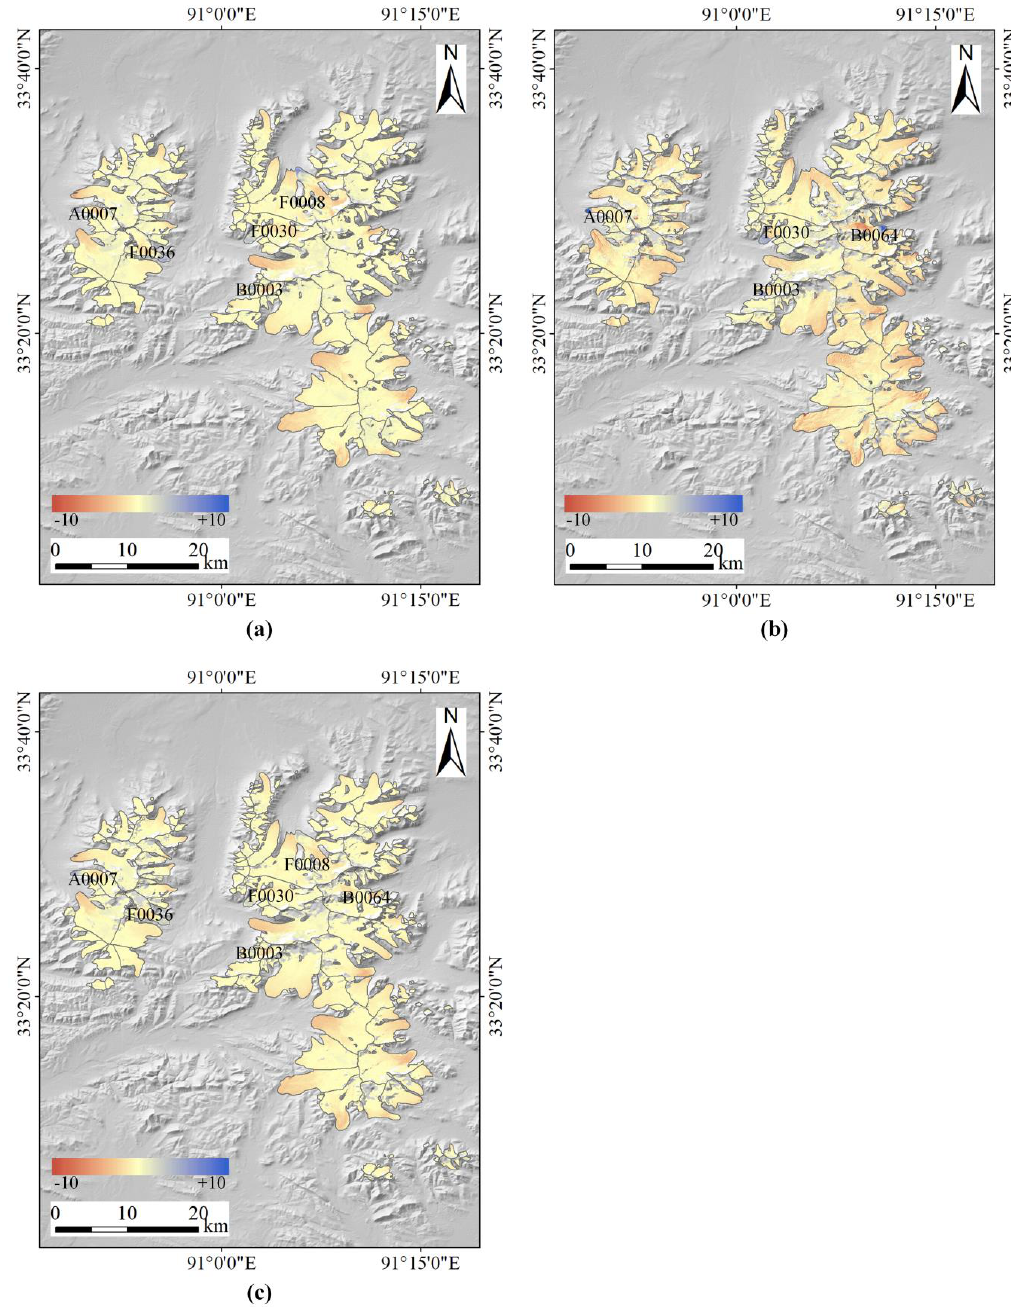
Figure 2. Observed annual glacier elevation changes (m yr − 1 ) over the GLDDM: ( a ) between 2000 and 2012; ( b ) between 2012 and 2018; ( c ) between 2000 and 2018. The glaciers with surging events in the studied periods are labeled as the last five codes of the WGMS (World Glacier Monitoring Service)